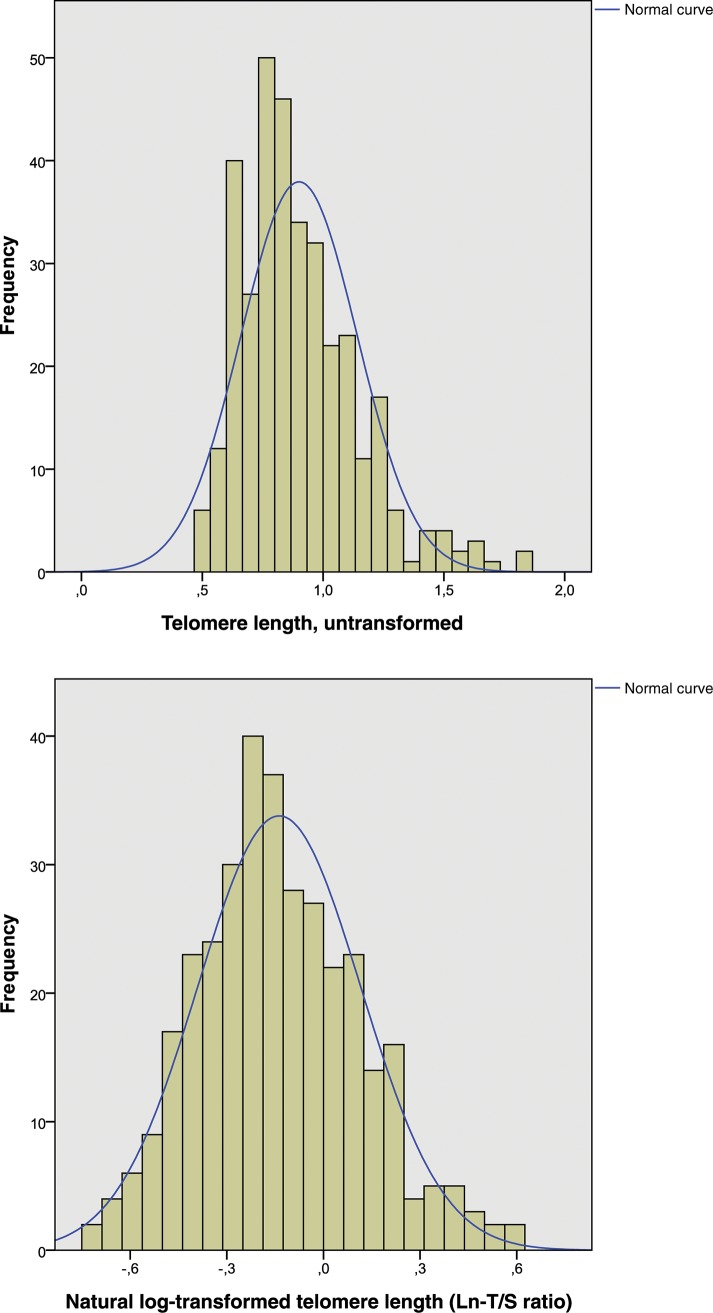
Telomere length (untransformed) in all patients, n = 343 (A); Telomere length (natural log-transformed) in all patients, n = 343 (B).T/S was non-normally distributed (A). A natural log-transformation was performed to obtain a near-normal distribution (B).